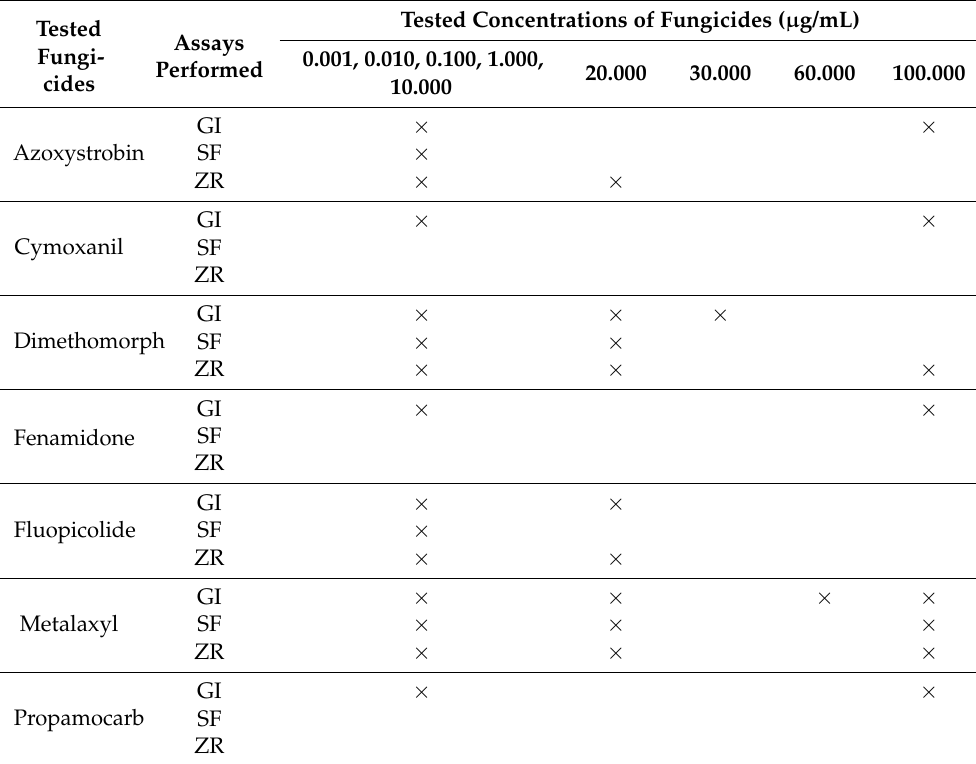
Table 2. The tests performed on Phytophthora cactorum isolates at different concentrations of partic- ular